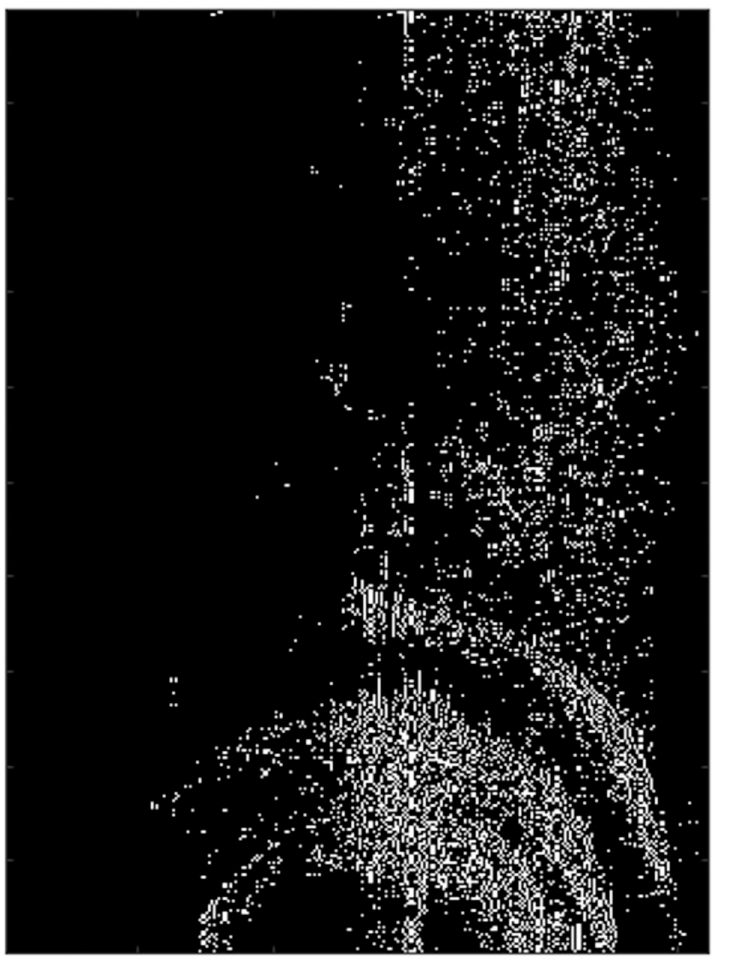
Fig 12. The result of extraction of SAR image feature points by Prewitt operator. PMEA algorithm is based on MEA algorithm and does not rely on strong scattering points.